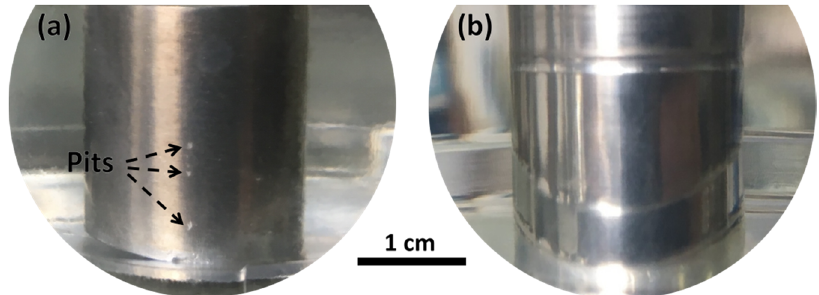
Fig. 7 Immersion corrosion test results of Al – Mn alloys. a CG sample and b GG